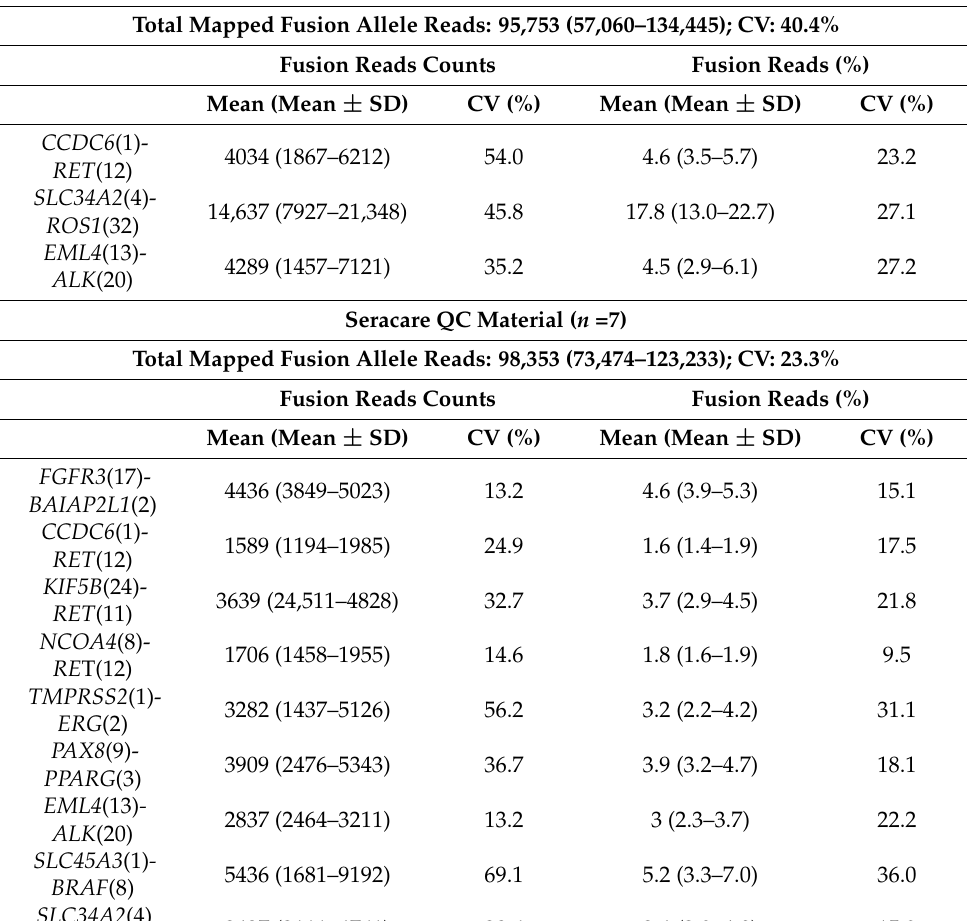
Table 4. Inter-run variation for gene-fusion and exon skipping detection in QC samples. HD784 QC Material ( n